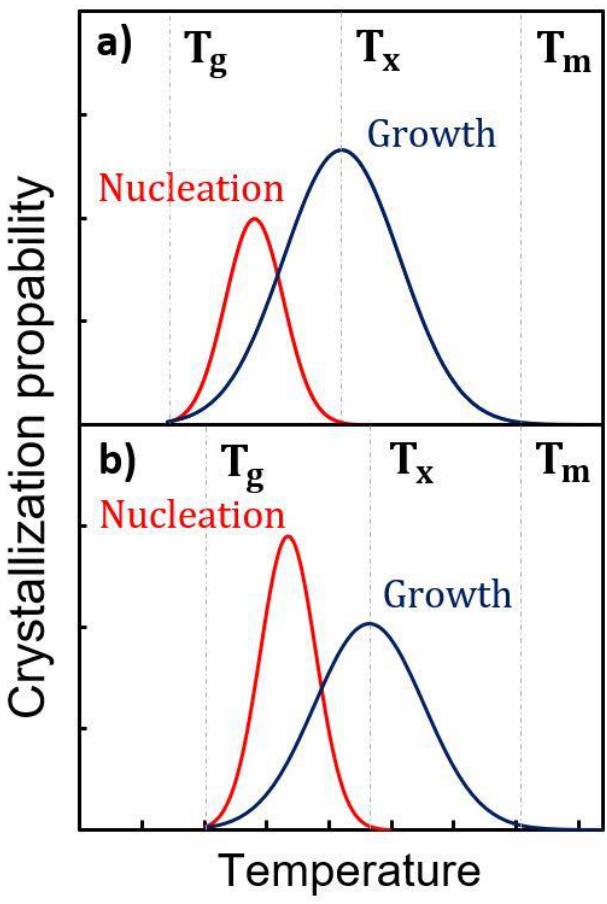
Figure 5. Schematic illustrations of nucleation dominated kinetics for undoped GST-225 ( a ) and N-implanted GST-225 ( b ). T g , T x and T m are the glass transition, the crystallization and the melting temperatures, respectively.